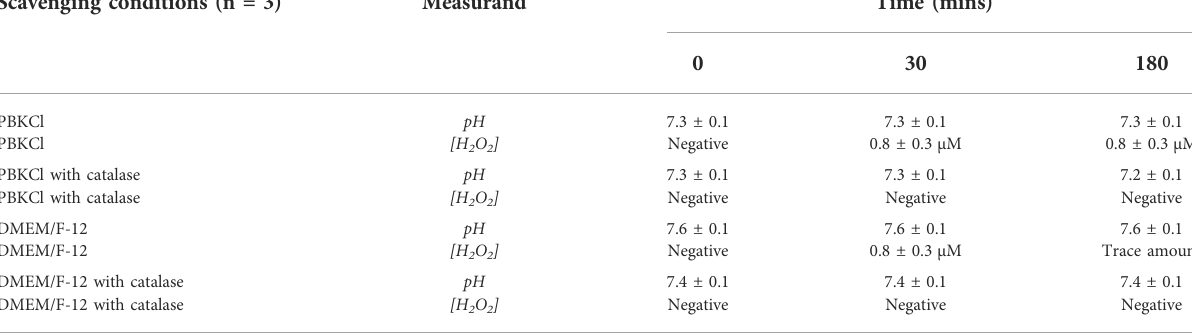
TABLE 3 pH and H 2 O 2 concentration under eLOS oxygen